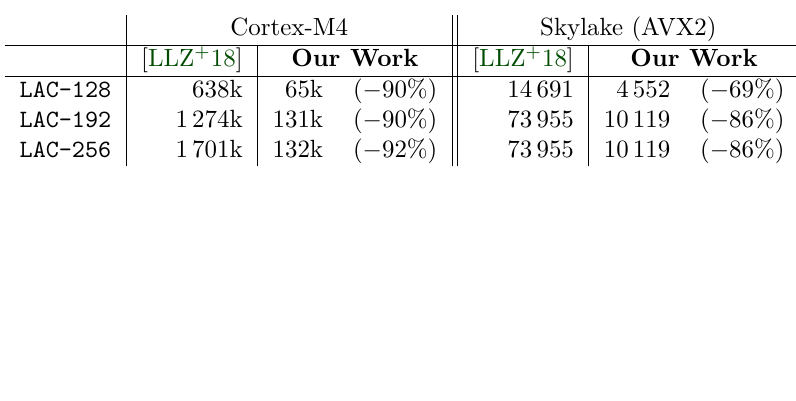
Table 9: LAC polynomial multiplication clock cycles on Cortex-M4 and